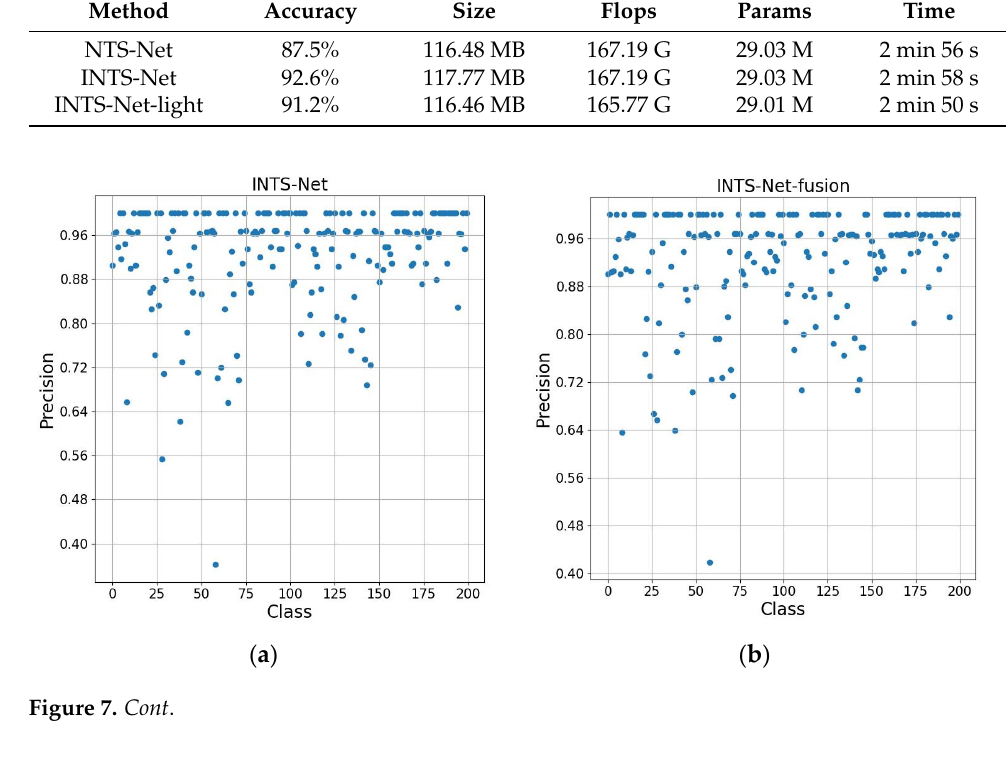
( d ) Figure 7. Precision and recall in each category. ( a , c ) are the results before fusing BN and CNN. ( b , d ) are the results after fusing BN and CNN. 5. Conclusions In this paper, we improved the NTS-Net and proposed the INTS-Net model, which adds the noise injection method SPS and fuses batch normalization and convolution in runtime. We also made flexible adjustments to make the two methods more compatible with the NTS-Net network. The method gives full play to its role in suppressing over- active neurons and enhances the balance. Experiments against state of-the-art methods exhibit the superior performance of our method on various fine-grained recognition tasks. Also, our proposed method is lightweight, easy to train, and agile for inference. Author Contributions: Conceptualization, J.X. and H.J.; methodology, J.X. and J.Z.; software, J.X.; validation, H.J., J.Z. and S.Z.; formal analysis, H.J.; investigation, H.J. and J.Z.; resources, J.X.; data curation, J.X.; writing—original draft preparation, J.X.; writing—review and editing, J.X., S.Z., T.W., S.L. and Z.L.; visualization, J.X.; supervision, H.J., J.Z. and S.Z.; project administration, H.J. and J.Z. All authors have read and agreed to the published version of the manuscript. Funding: This work was financially supported by Industry-University-Research Innovation Foun- dation of Chinese University (2021LDA06003) and Science and Technology Project of Hebei Educa- tion Department (QN2020423).